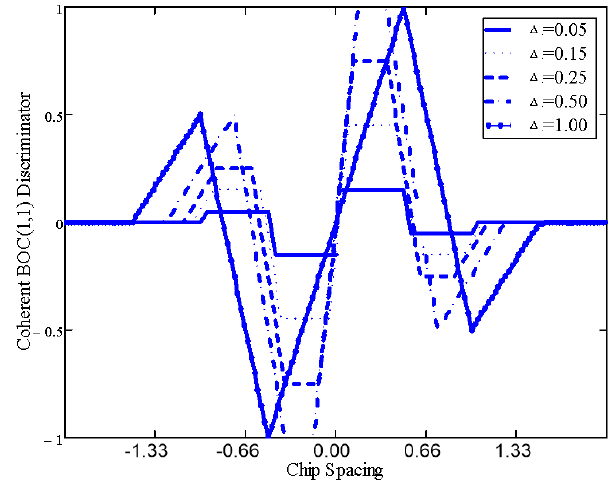
Figure 7. Effect of Correlator Spacing ( (cid:2722) (chip)) on a BOC(1,1) Coherent EML Discriminator (assuming an infinite front-end bandwidth).